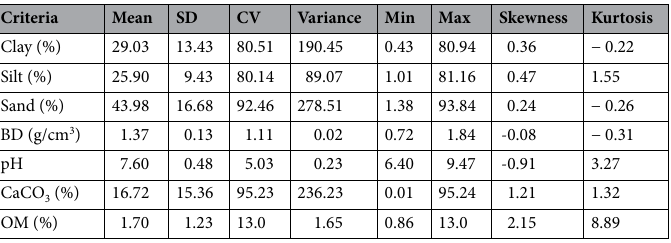
Interpolation models